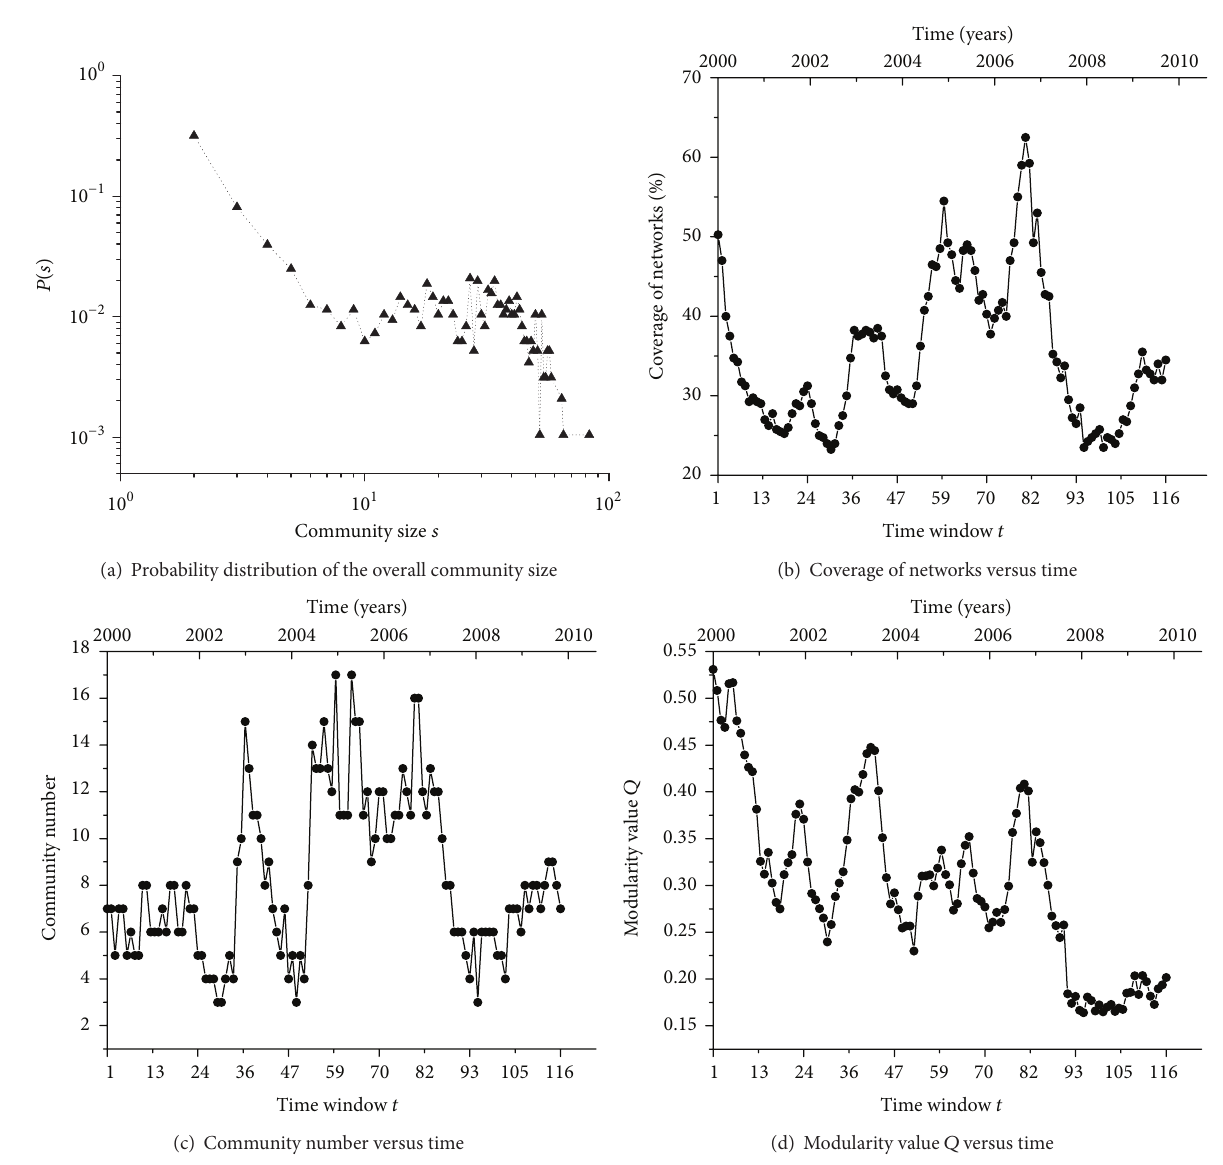
Figure 6: Plots of several basic statistic properties of stock